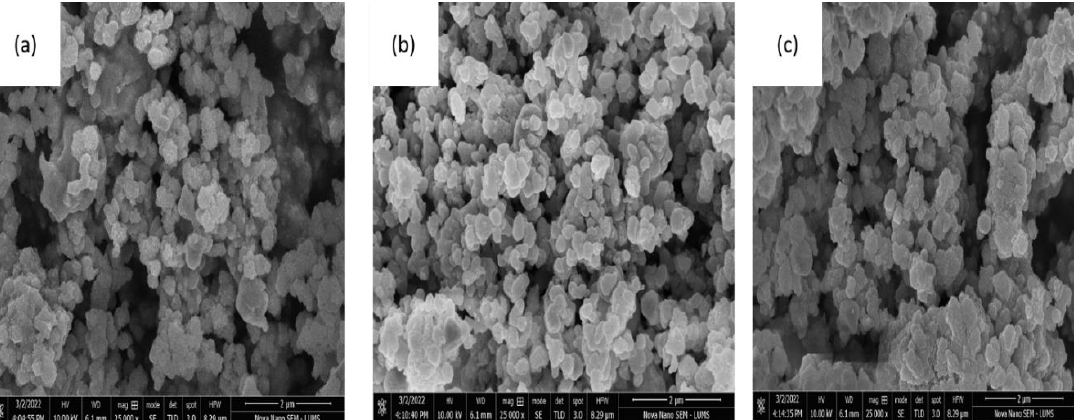
Figure 4. ( a ) SEM image of 0.5 Ag/TiO 2 composite. ( b ) SEM image of 0.01 Ag/TiO 2 composite. ( c ) SEM image of 0.1 Ag/TiO 2 composite.